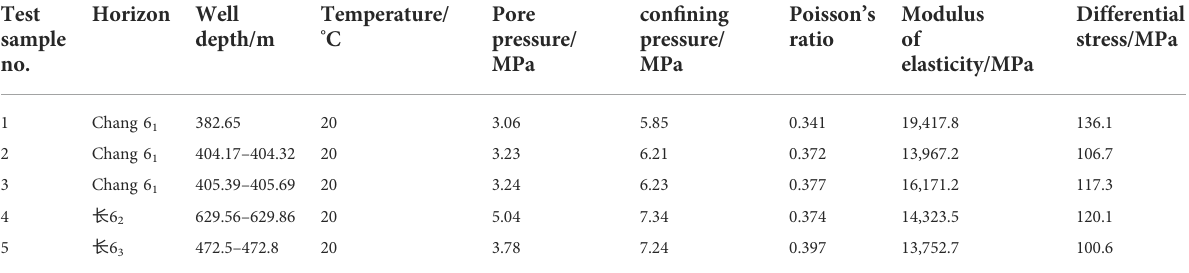
TABLE 1 Test results of rock mechanical parameters in Zhengzhuang block. Test